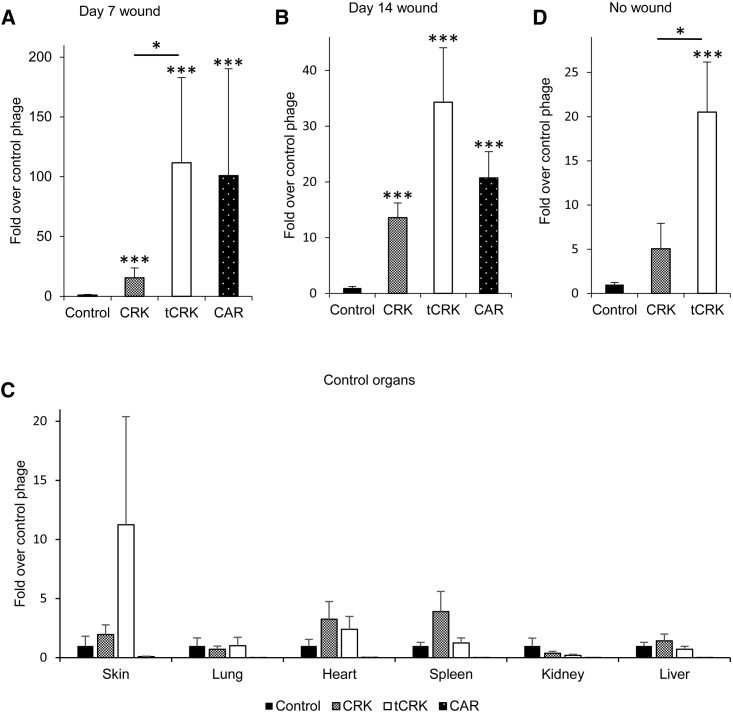
Homing of tCRK PhageThe amounts are represented as fold over control phage. (A) Phage homing in 7-day-old wound. n = 8 for tCRK and CRK, n = 5 for CAR, and n = 7 for control phage. (B) Phage homing in 14-day-old wound. n = 7 for tCRK, CRK, and CAR, and n = 5 for control phage. (C) Phage homing in control organs. n = 11 for tCRK and control phage, n = 10 for CRK, and n = 5 for CAR. (D) Phage homing in unwounded skin. n = 7 for all phages. Error bars represent SEM. ∗p < 0.05, ∗∗p < 0.01, ∗∗∗p < 0.001, Kruskal-Wallis test with Bonferroni post hoc test.